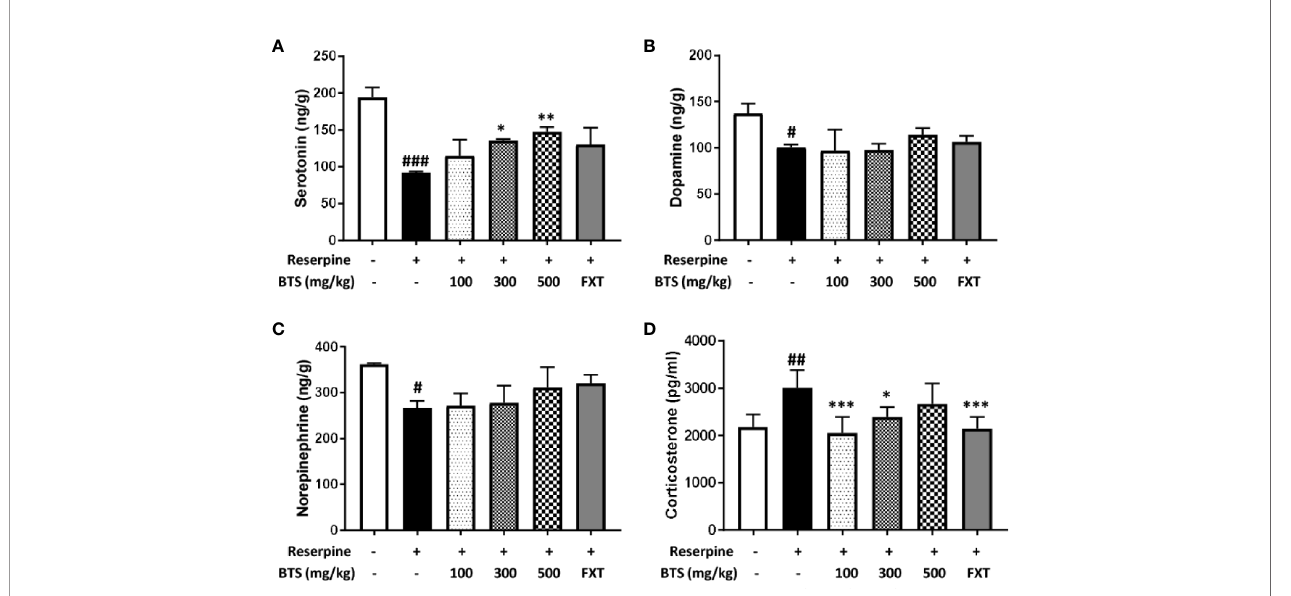
FIGURE 2 | Effects of BTS on monoamines and serum levels of corticosterone in reserpine-induced depression in mice. (A) Serotonin, (B) dopamine, and (C) norepinephrine levels in the brain were measured by electrospray ionization mass spectrometry. (D) Serum levels of corticosterone were determined by ELISA. The data represent the mean ± SD of triplicate determinations (n = 6, one-way ANOVA: # p < 0.05, ## p < 0.01, ### p < 0.001 vs. control; *p < 0.05, **p < 0.01, ***p < 0.001 vs.